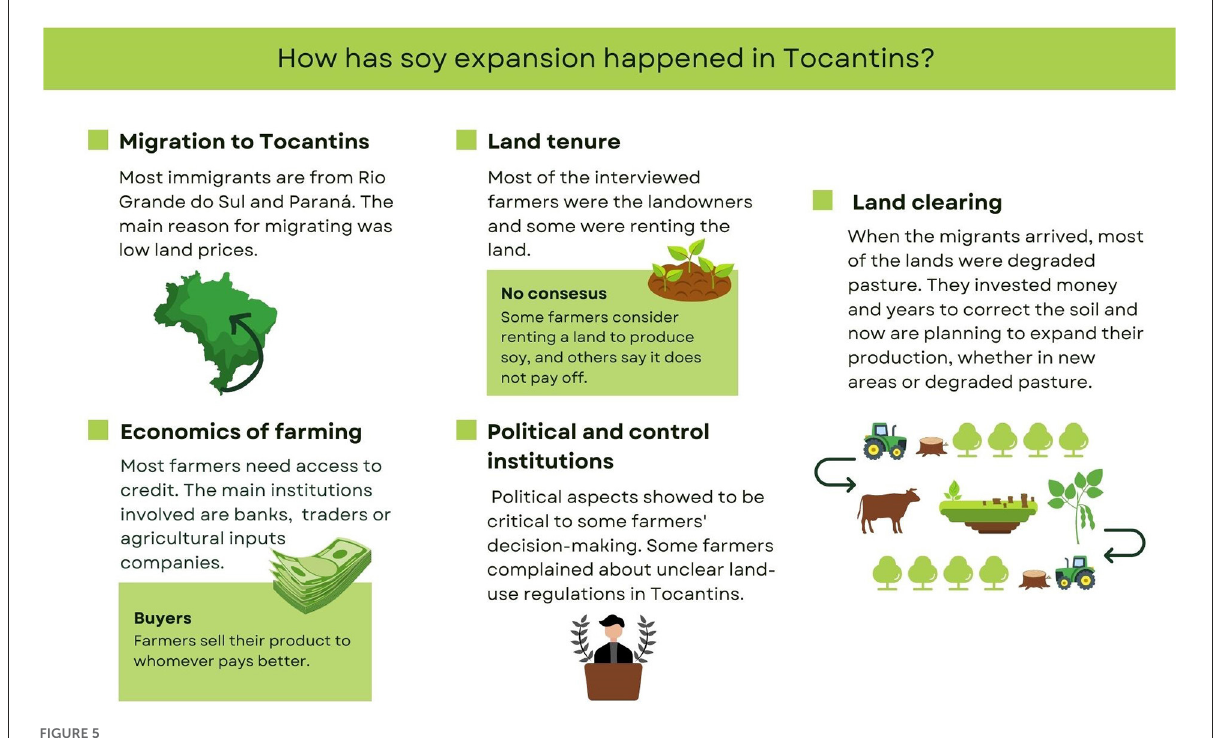
FIGURE5 Soy deforestation economy in